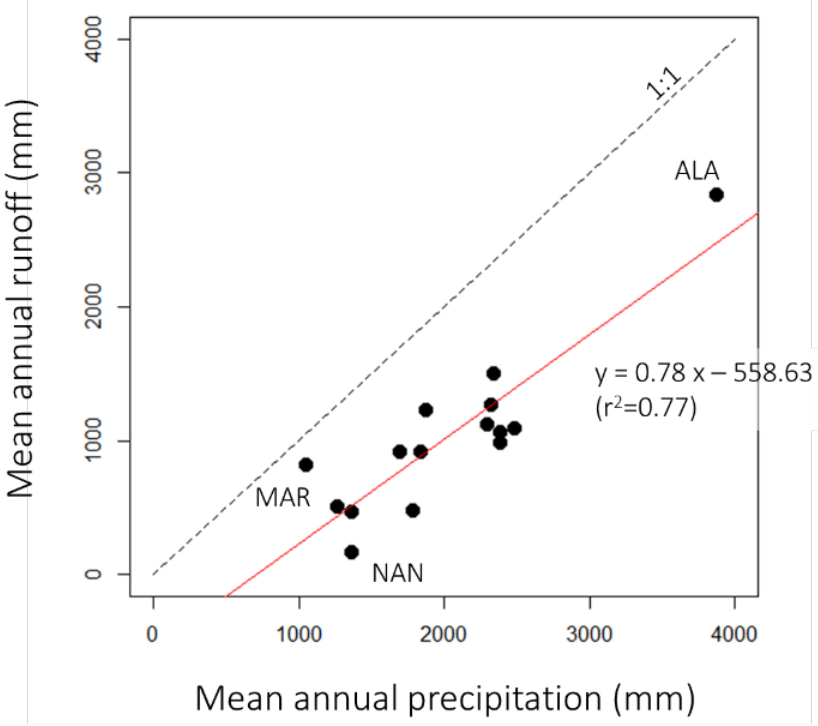
Figure 2. Regression of mean annual runoff against mean annual